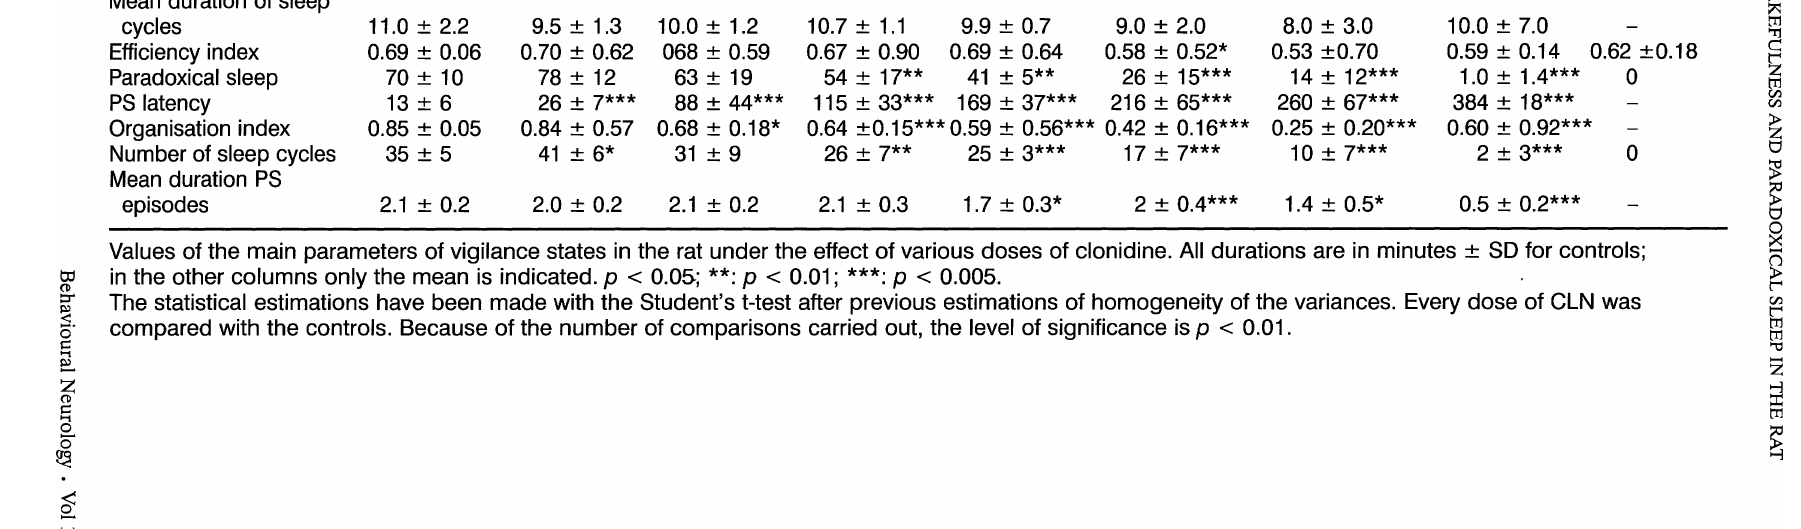
Paradoxical sleep